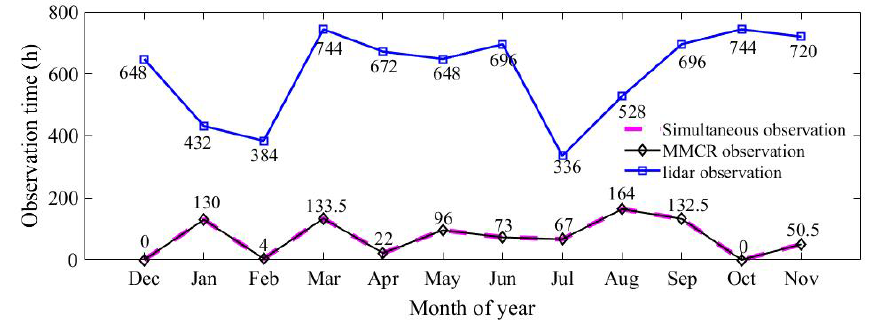
Figure 15. Monthly observation hours of lidar and MMCR. Table 3. Cloud bottom height recording